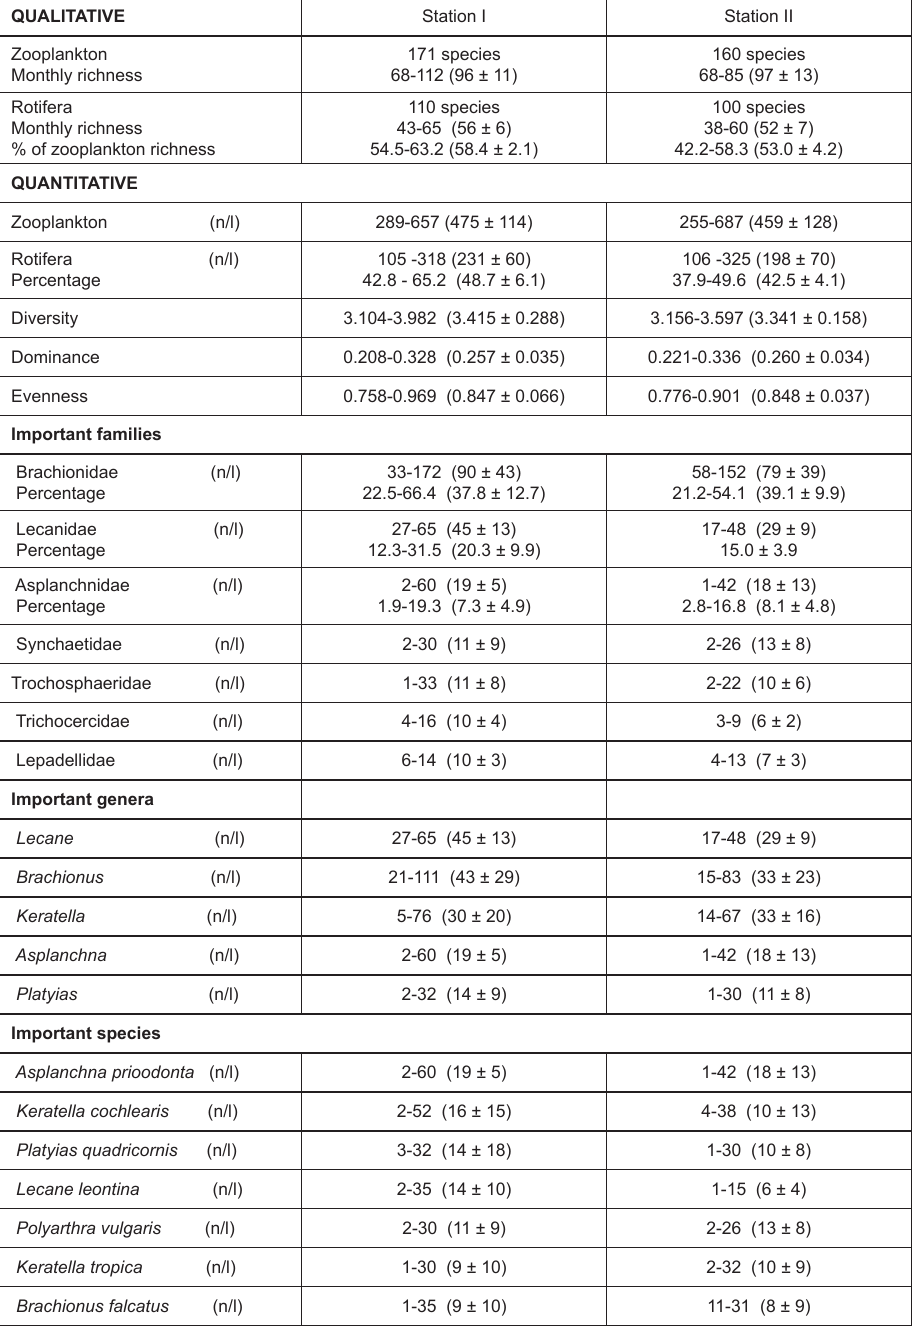
Table 2. Temporal variations of rotifer